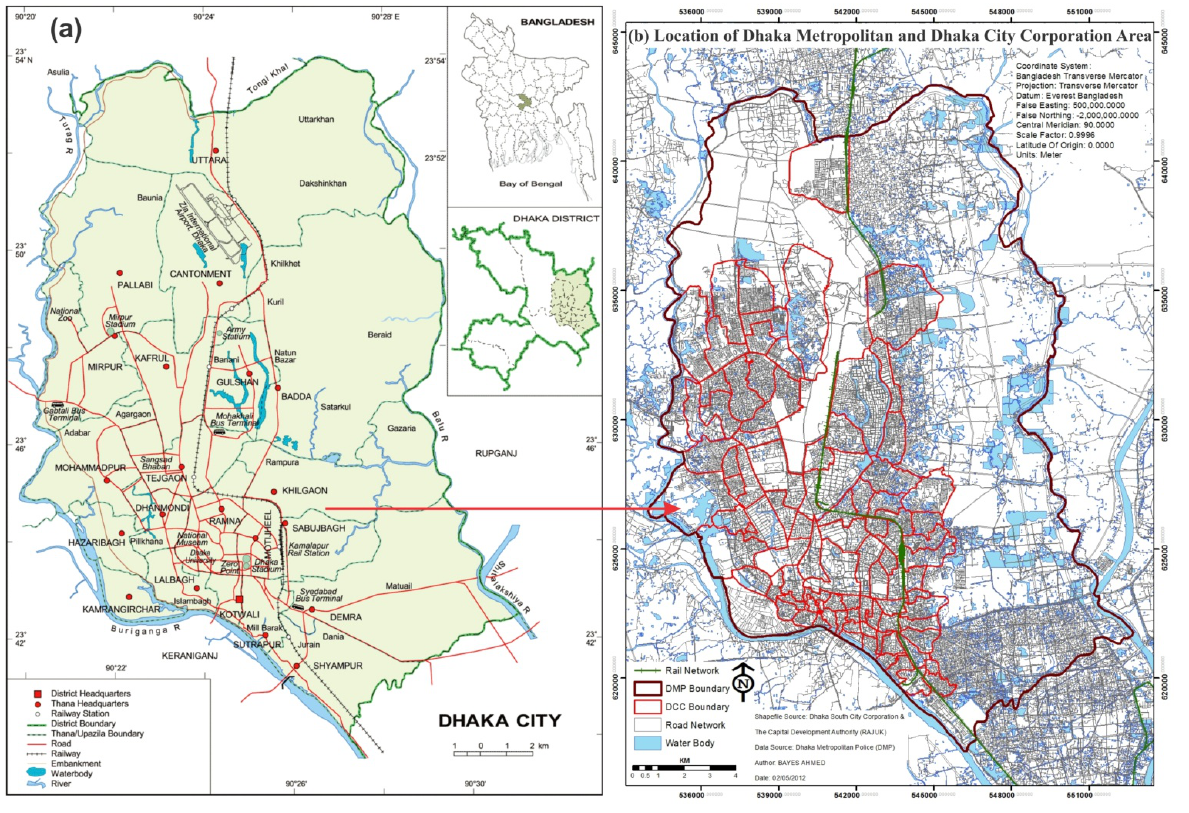
Figure 1. Location of Dhaka Metropolitan (DMP) area ( a ) in Bangladesh and ( b ) in Dhaka City Corporation (DCC). Source: ( a ) Banglapedia, National Encyclopedia of Bangladesh, 2012, and ( b ) The Capital Development Authority ( RAJUK ), Dhaka,